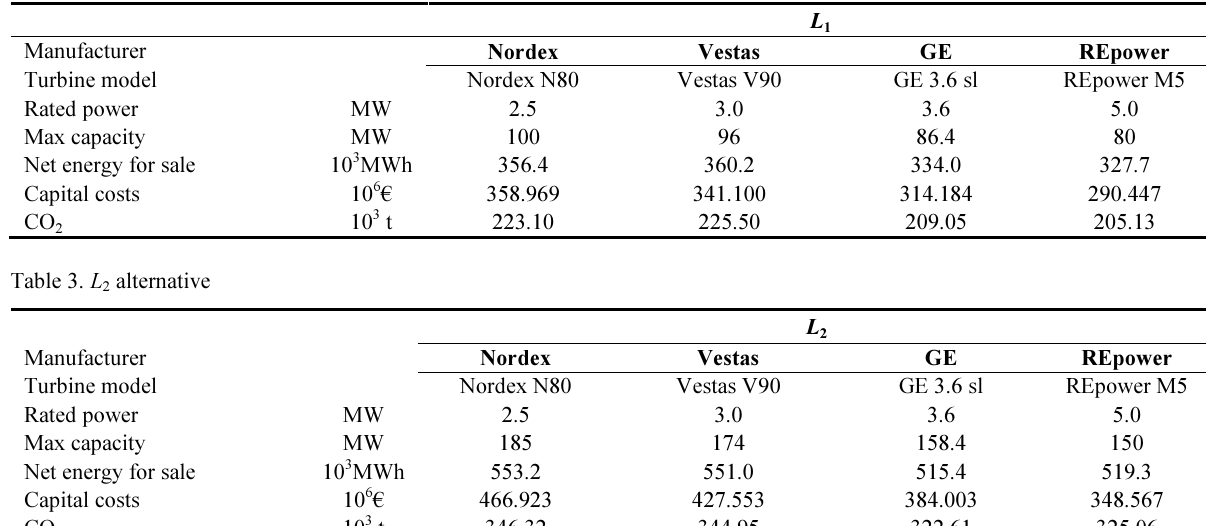
Table 2. L 1 alternative